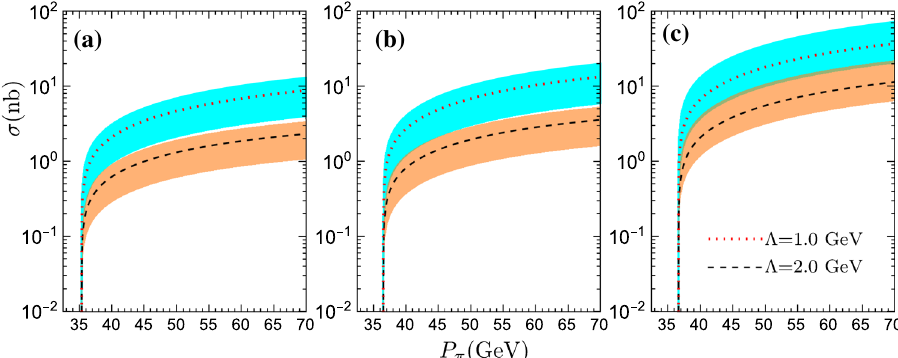
Fig. 2 The cross sections for π p → Z ( 3900 ) P c c depending on the momentum of pion beam. Diagrams a , b and c correspond to cross sections for P c ( 4312 ) , P c ( 4440 ) , and P c ( 4457 ) production, respectively. The bands indicate the uncertainties of the cross sections resulted from the relevant coupling